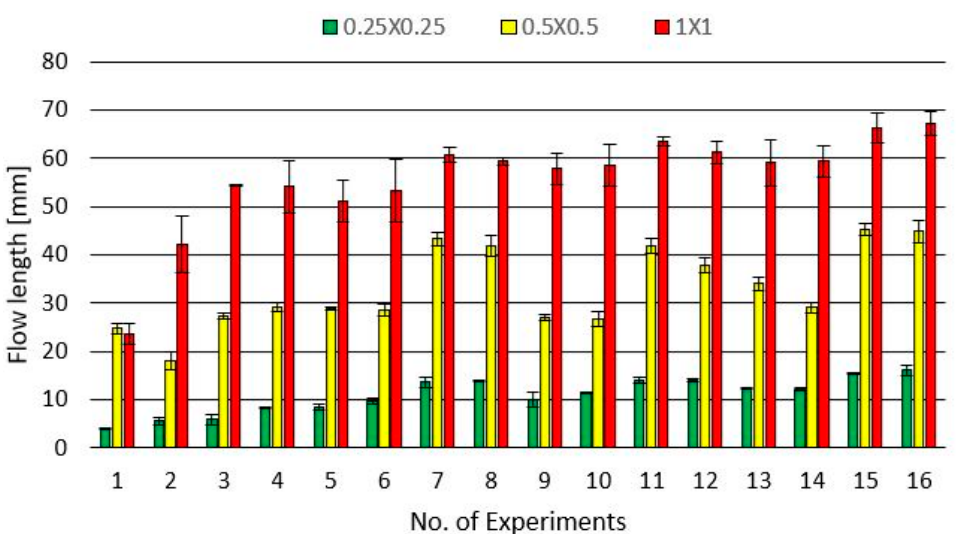
Figure 6. Achievable flow lengths for spiral geometries with different cross sections and for different process parameters.